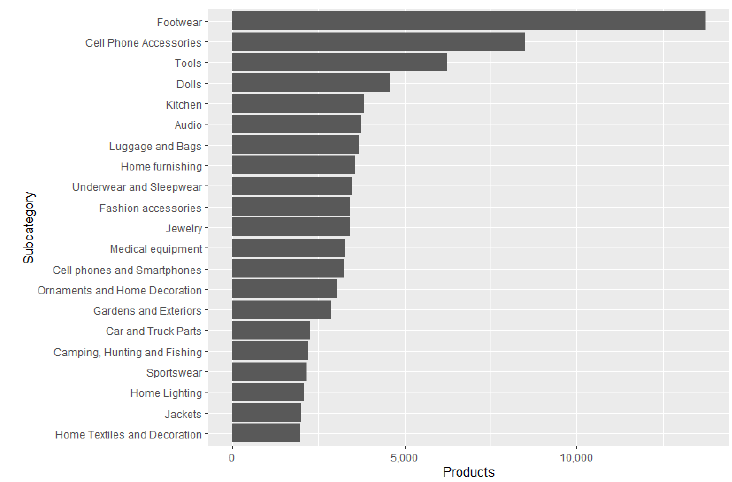
Figure A4. Number of products within the main subcategories.